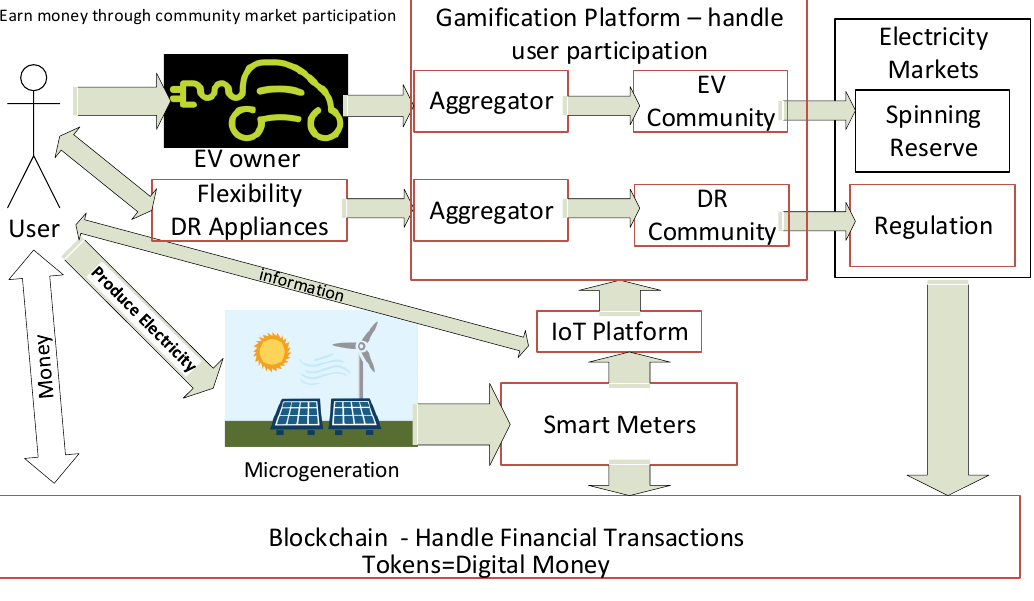
Figure 1. Outline of the main work goals to create electrical vehicle (EV) and demand response (DR) community market players and to decentralize financial transactions based on blockchain.